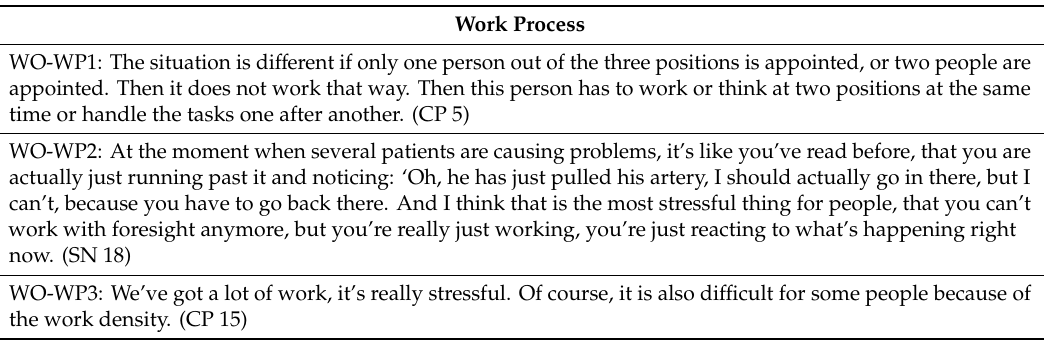
Table A5. Selected quotes of the participants related to work